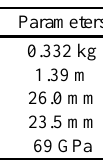
Fig. 2. Schematic diagram of experimental set-up for bean bag vibroimpact system. Table 1 Parameters of primary